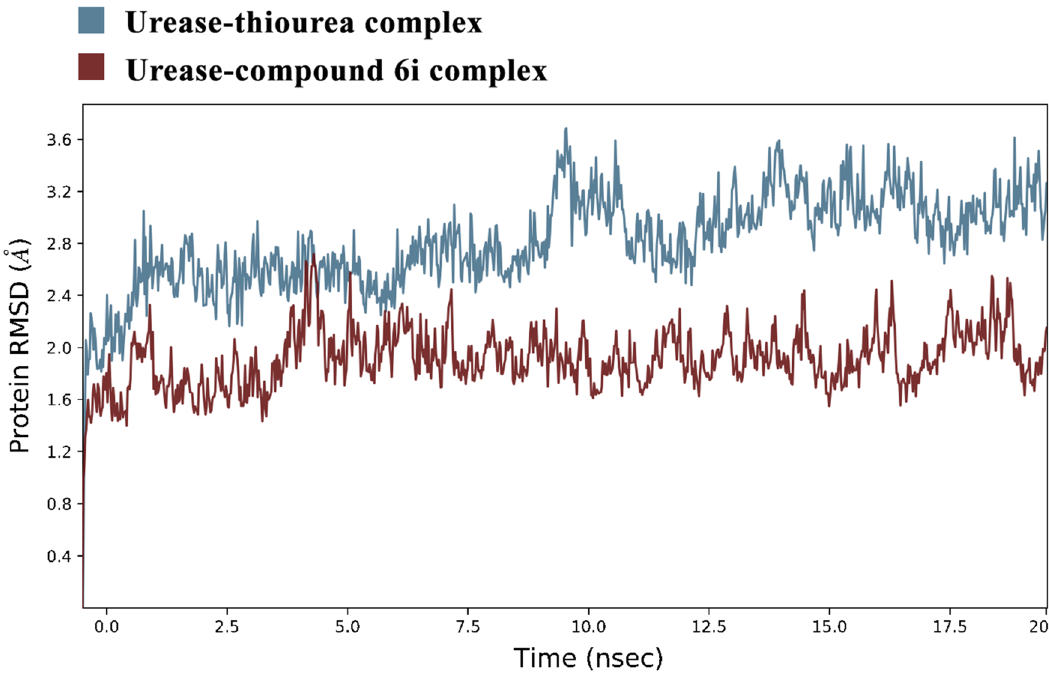
Figure 4. RMSD plots of the urease backbone complexed with compound 6i (red) and thiourea